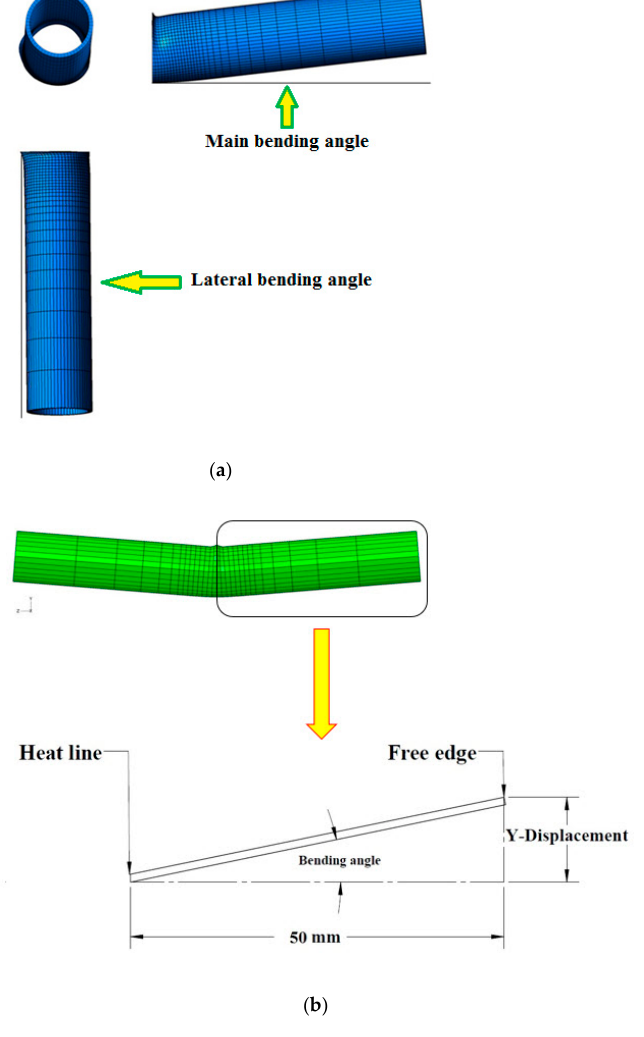
Figure 2. ( a ) Schematic views of main and lateral bending angles, ( b ) Schematic view of the main bending angle relevant to Y-displacement for a laser-bent tube. Table 1. The irradiation scheme and irradiation length in experimental